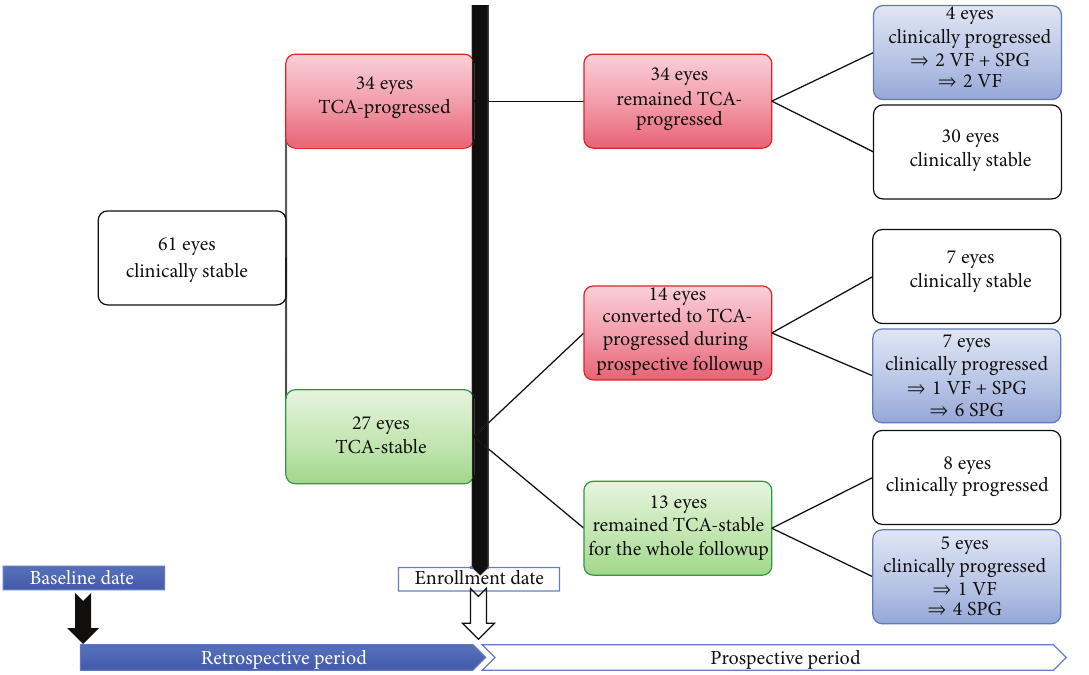
Figure 2: Study flow chart. VF: visual field; SPG: stereophotograph; TCA: Topographic change